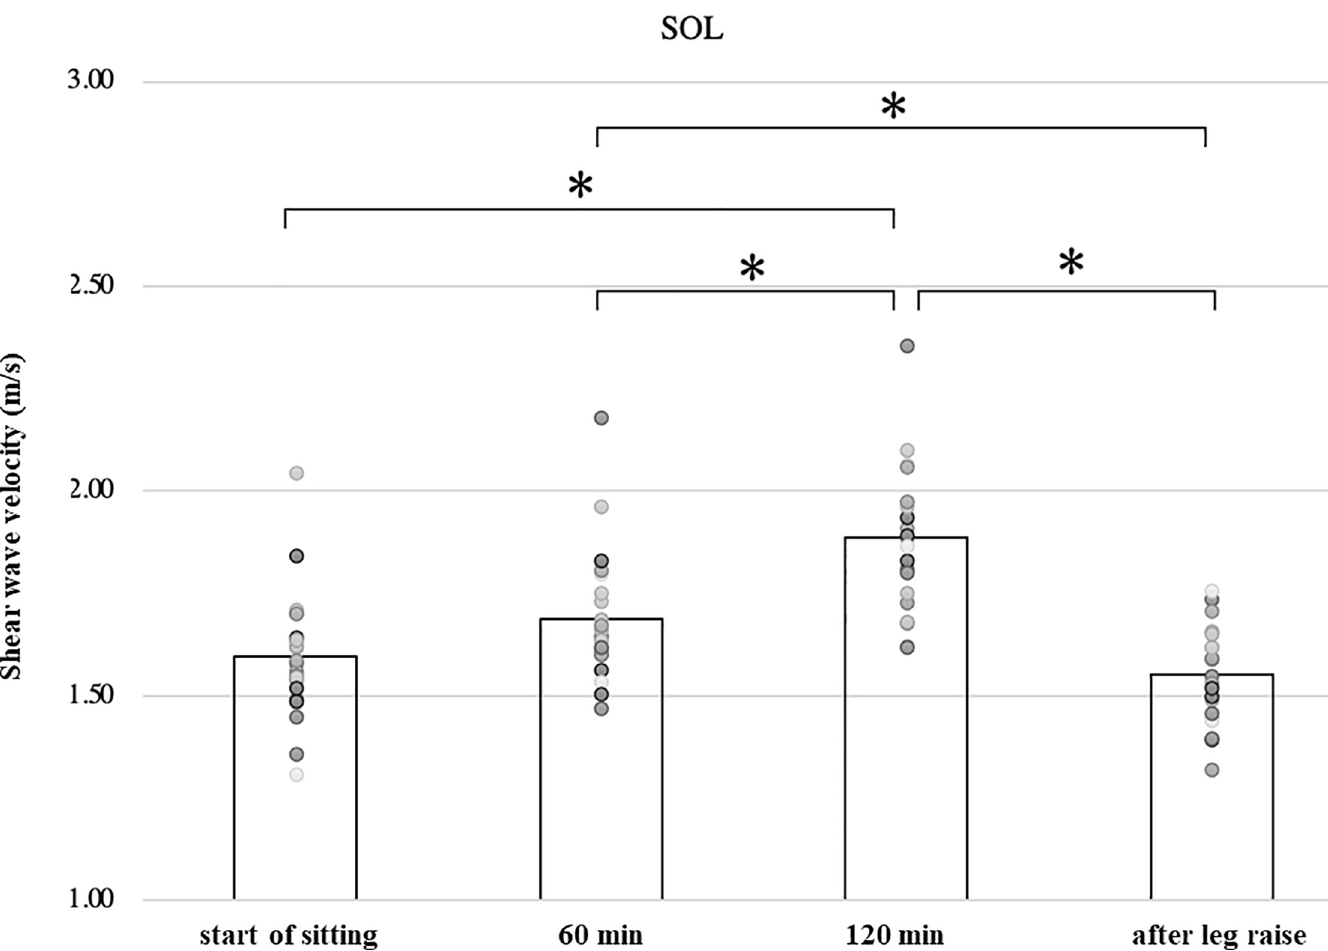
Fig 7. Shear wave velocity of the